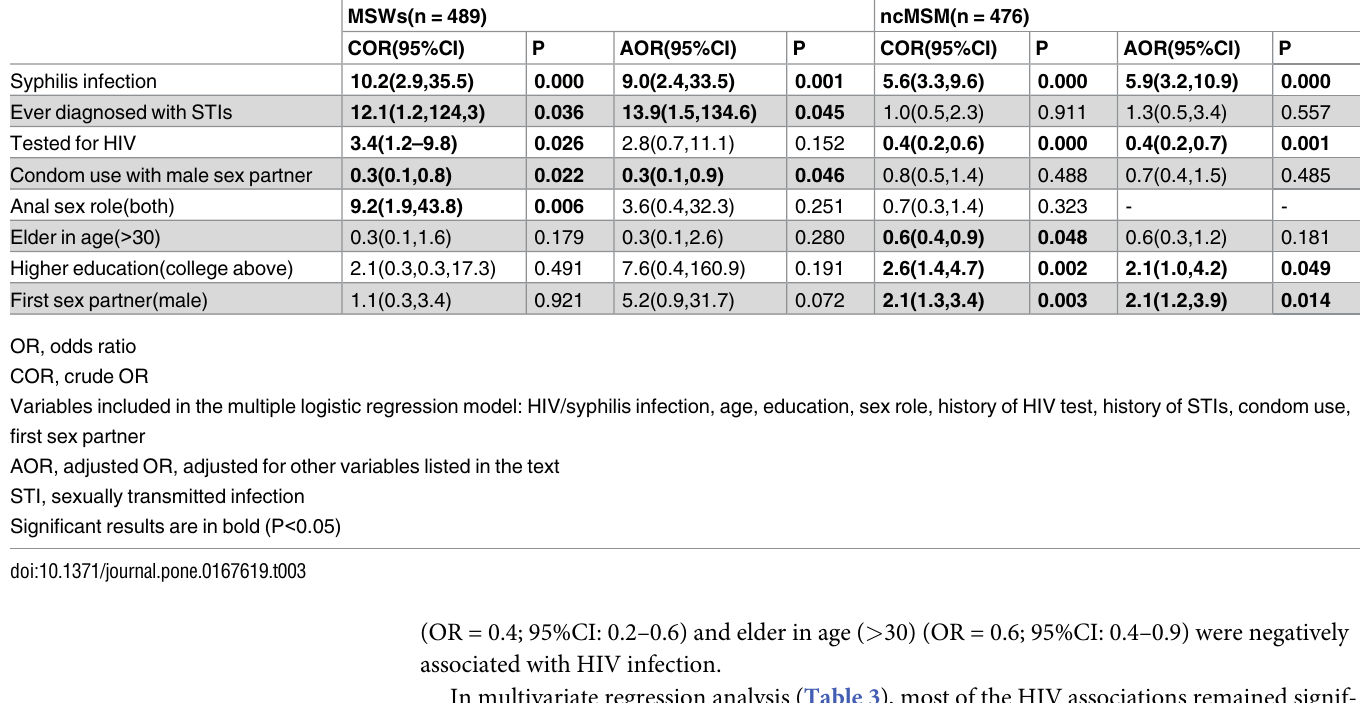
Table 3. Estimated HIV risk/prevention behavior in MSWs and